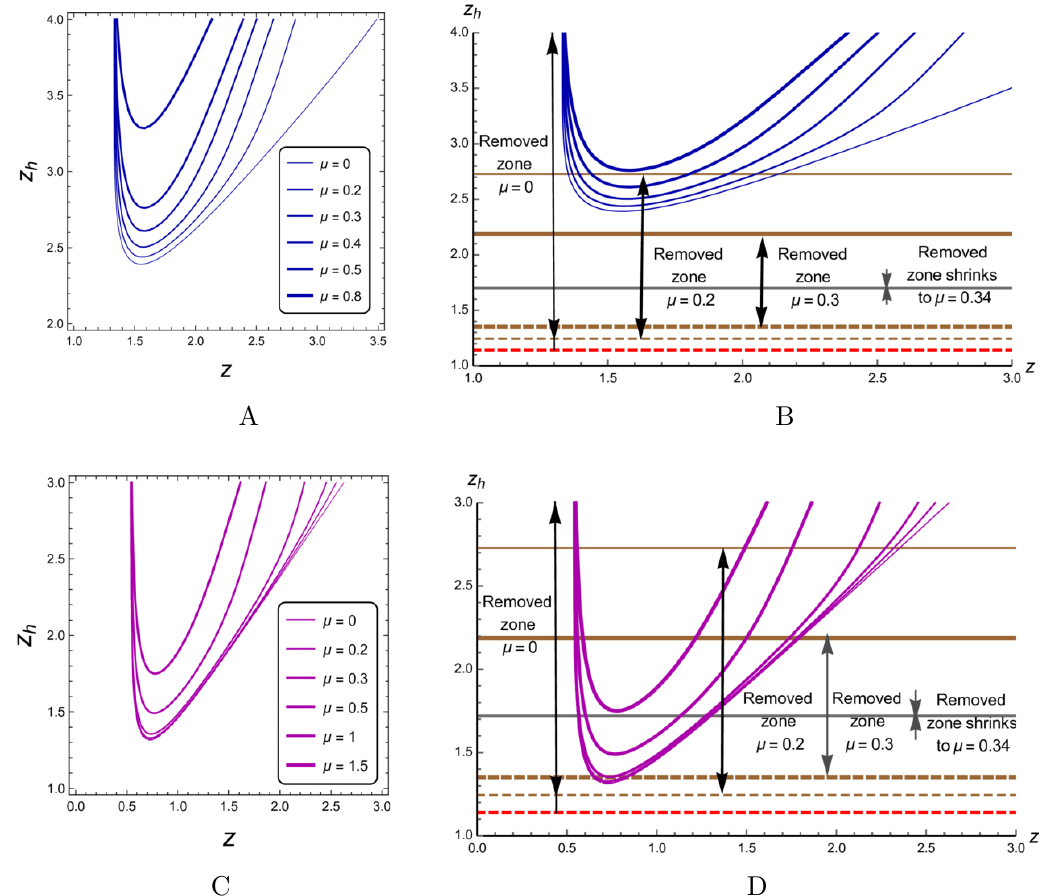
Figure 40 . The location of extreme points of e(cid:11)ective potential in the anisotropic case (cid:23) = 4 : 5, c = (cid:0) 1 for di(cid:11)erent z h , (cid:22) and di(cid:11)erent orientations of quark pairs are shown by lines of di(cid:11)erent thickness depending on the values of the chemical potential, and colors, for the Wilson longitudinal line W x (A and B) with dark blue and for the Wilson transverse line W y with dark purple lines (B and D). B) and D). The location of the instability zones corresponding to di(cid:11)erent (cid:22) is shown by black lines with